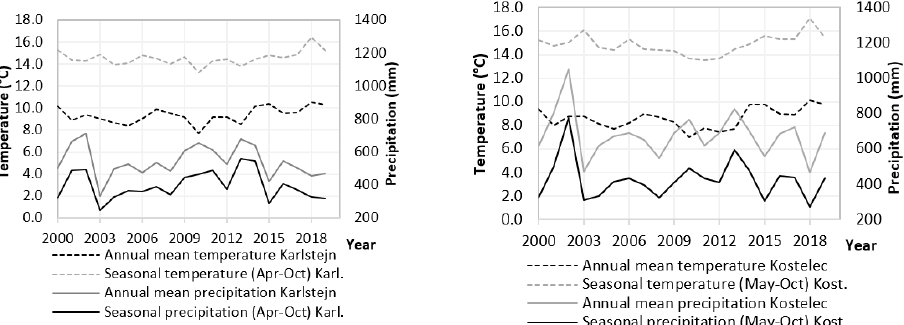
Figure 2. Dynamics of annual and seasonal temperature and seasonal precipitation for the Karlstejn and Cukrak ( left ) and Kostelec ( right ) sites, according to nearby meteorological stations, for the period 2000–2018. Note : Karl.—Karlstejn research plot, Kost.—Kostelec research plot.